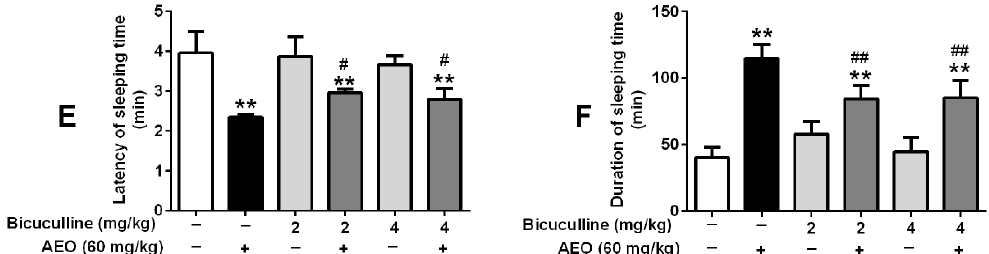
Figure 6. Effects of the GABA A receptor antagonist bicuculline on locomotor activity and pentobarbital-induced sleeping: ( A ) total distance ( B ) distance moved, ( C ) time moved and ( D ) average velocity were recorded over a 10-min session, 30 min after i.p. administration of AEO (60 mg/kg) or saline, followed by ( E ) latency of sleeping time and ( F ) duration of sleeping time recorded after the pentobarbital sodium (50 mg/kg) i.p. injection. The results are presented as mean ± SEM with n = 8. ** p < 0.01 vs. control. # p < 0.05 and ## p < 0.01 vs. AEO 60 mg/kg group.